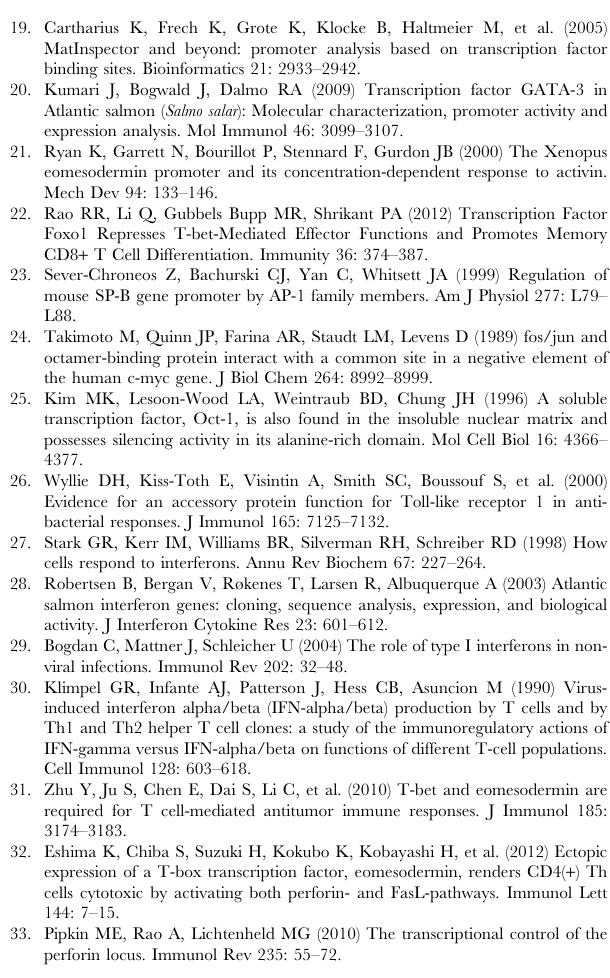
Figure S2 Phylogenetic tree showing the relationship between salmon Eomes and T-brain1 subfamily in other vertebrates. The phylogram was constructed with the MEGA 4.0 software using the neighbour-joining method based on an amino acid alignment (ClustalW) of the full-length protein. Numbers beside the internal branches indicate bootstrap values based on 10000 replications. The 0.05 scale indicates the genetic distance. Accession numbers for Eomes are listed in the legend of Fig. 2. The accession numbers of other T-brain1 subfamilies are as follows: Zebrafish Eomes 2, T-brain1, and Tbet ( NP_001077044,